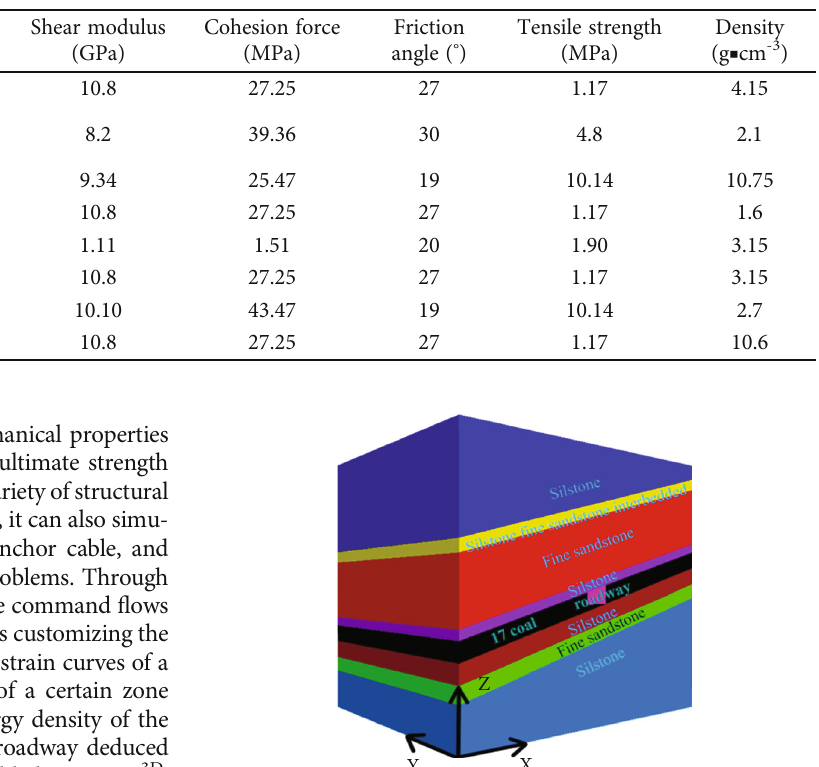
Table 1: Mechanical parameters and thickness of layers.